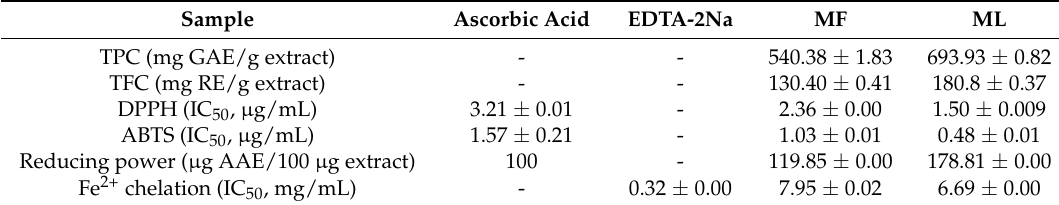
Table 1. Total phenolic content (TPC), total flavonoid content (TFC), and antioxidant activity of extracts prepared from Paeonia rockii .